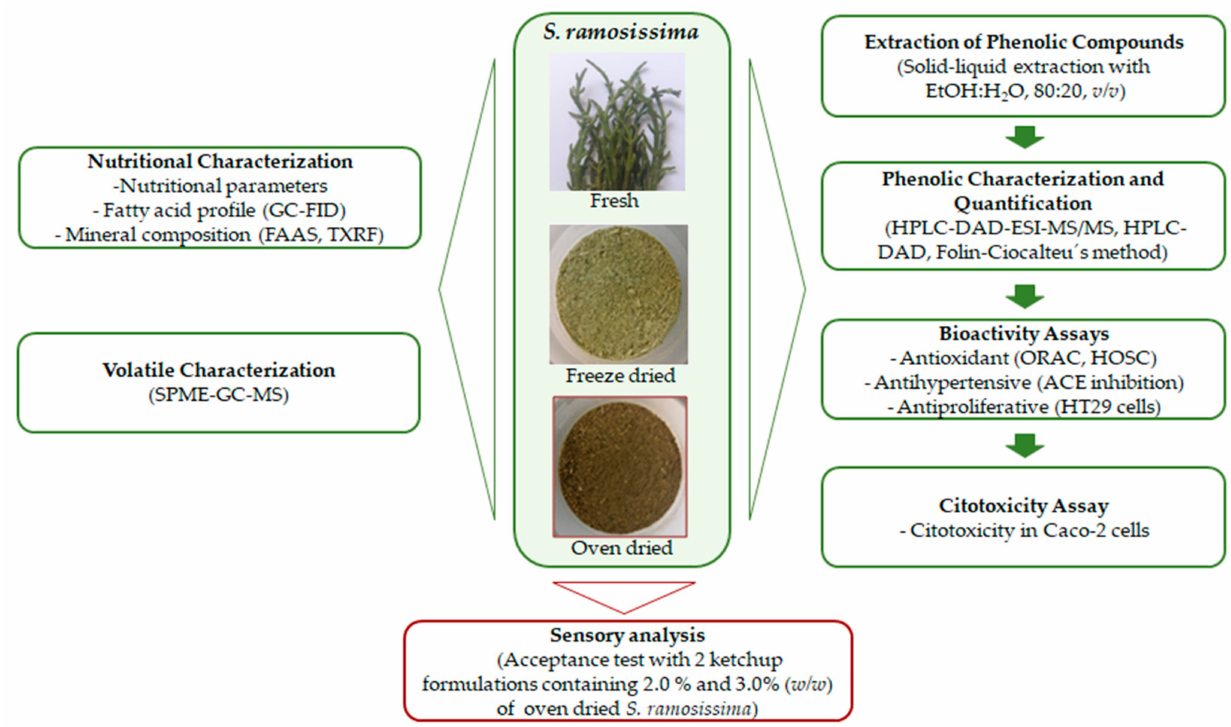
Figure 1. Scheme of the analyses and bioactivity assays of the fresh, oven, and freeze-dried S. ramosissima